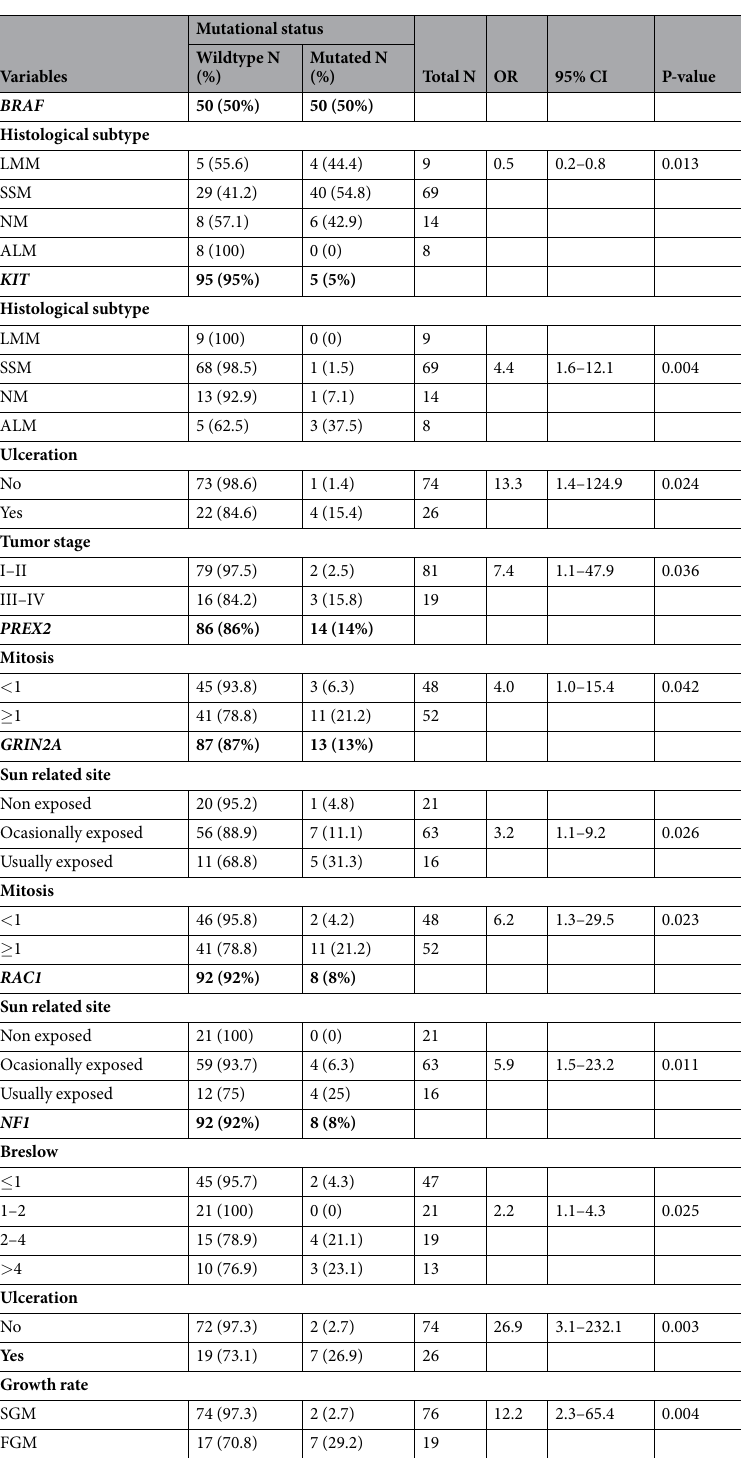
Table 2. Associations of mutations with clinicopathological characteristics. LMM: Lentigo maligna melanoma; SSM: Superficial spreading melanoma; NM: Nodular melanoma; ALM: Acral lentiginous melanoma; SGM: Slow growing melanoma; FGM: Fast growing